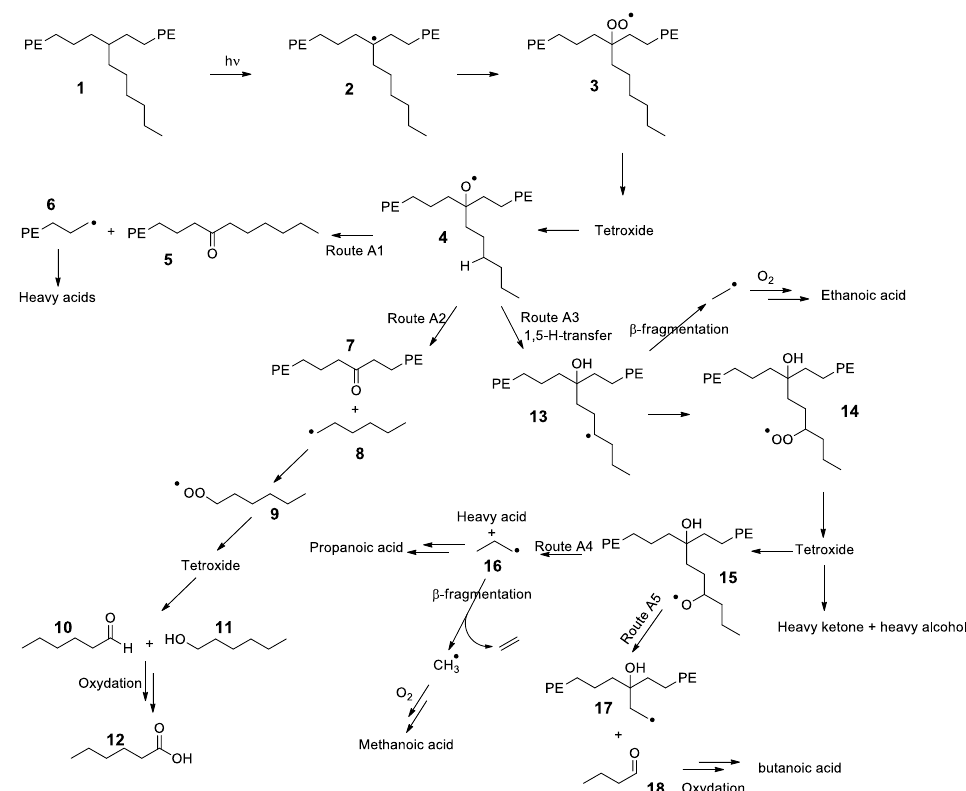
European Journal of Pharmaceutical Sciences.